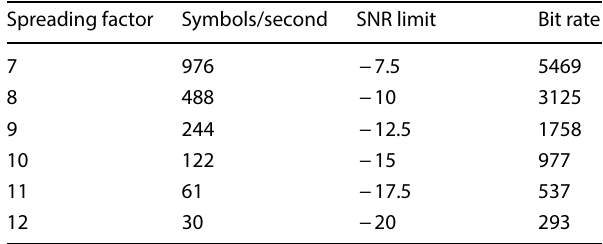
Table 3 LoRa spreading factors for 125 kHz bandwidth [19] Spreading factor Symbols/second